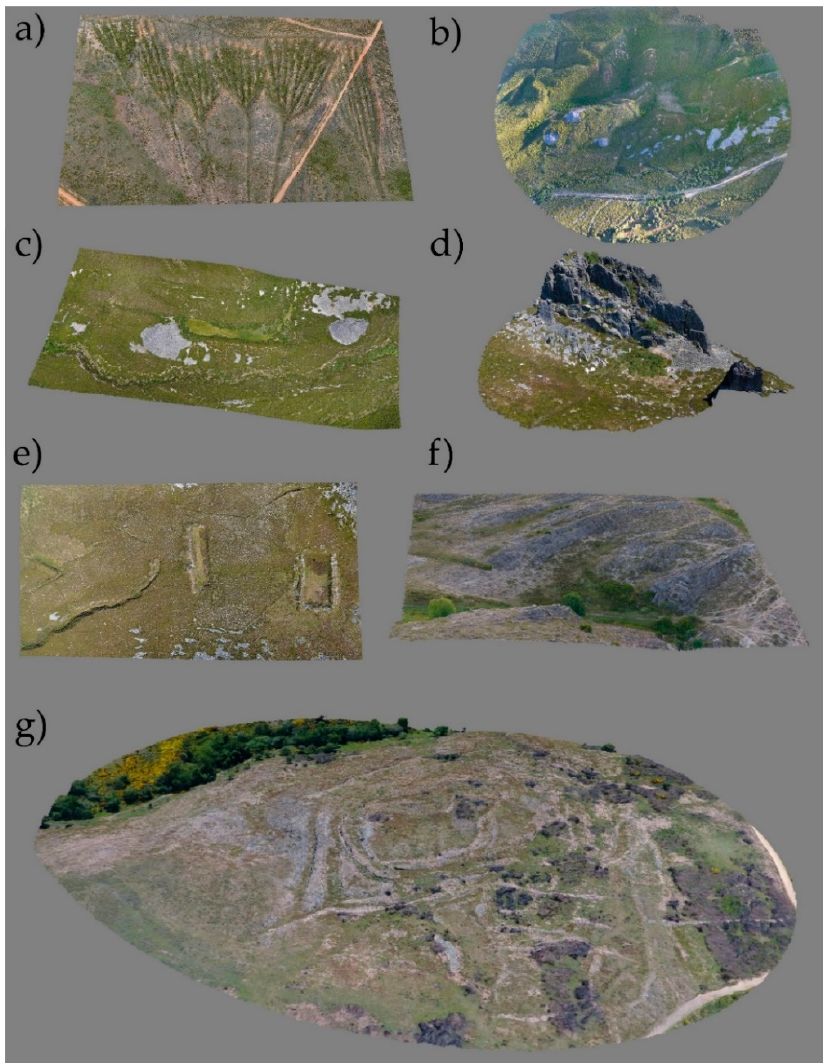
Figure 8. 3D texture models: ( a ) shallow open-cast mine (Model 1); ( b ) deep open-cast mine (Model 2); ( c ) tailing deposits (Model 3); ( d ) rock tunnel (Model 4); ( e ) stepped water reservoirs (Model 5); ( f ) supply canals (Model 6) and ( g ) mining camp (Model 7). Models available in Supplementary Materials (Figures S1–S7).